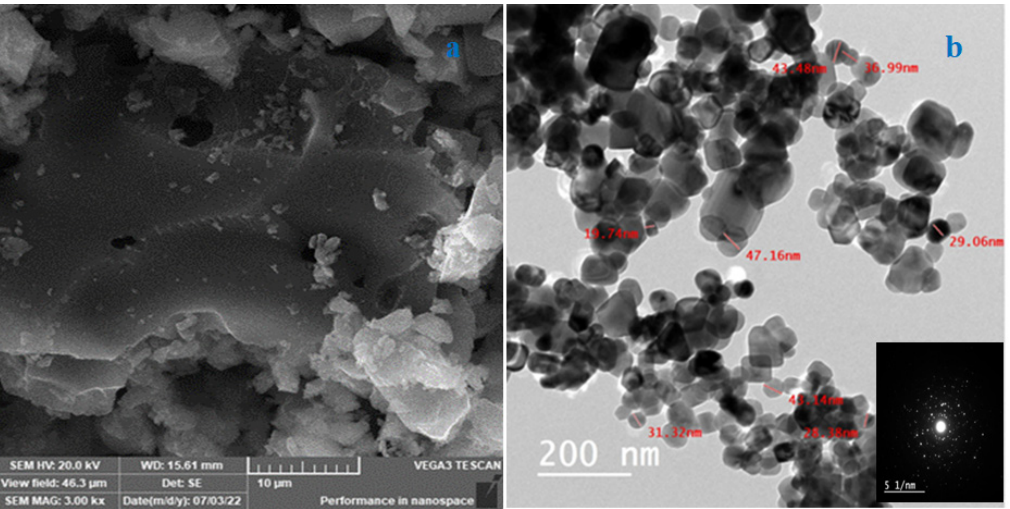
Figure 4. ( a ) Scanning electron microscopic image of Fe-AC; ( b ) transmission electron microscopic image of ZnO-NPs.